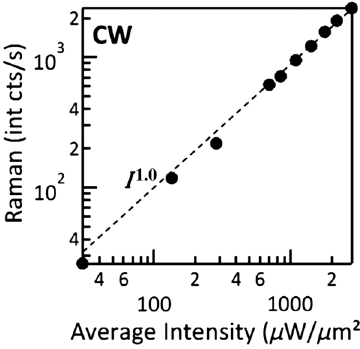
FIG. 6. Raman intensity of a bulk biphenyl-4-thiol sample, as a function of 633-nm CW excitation intensity.